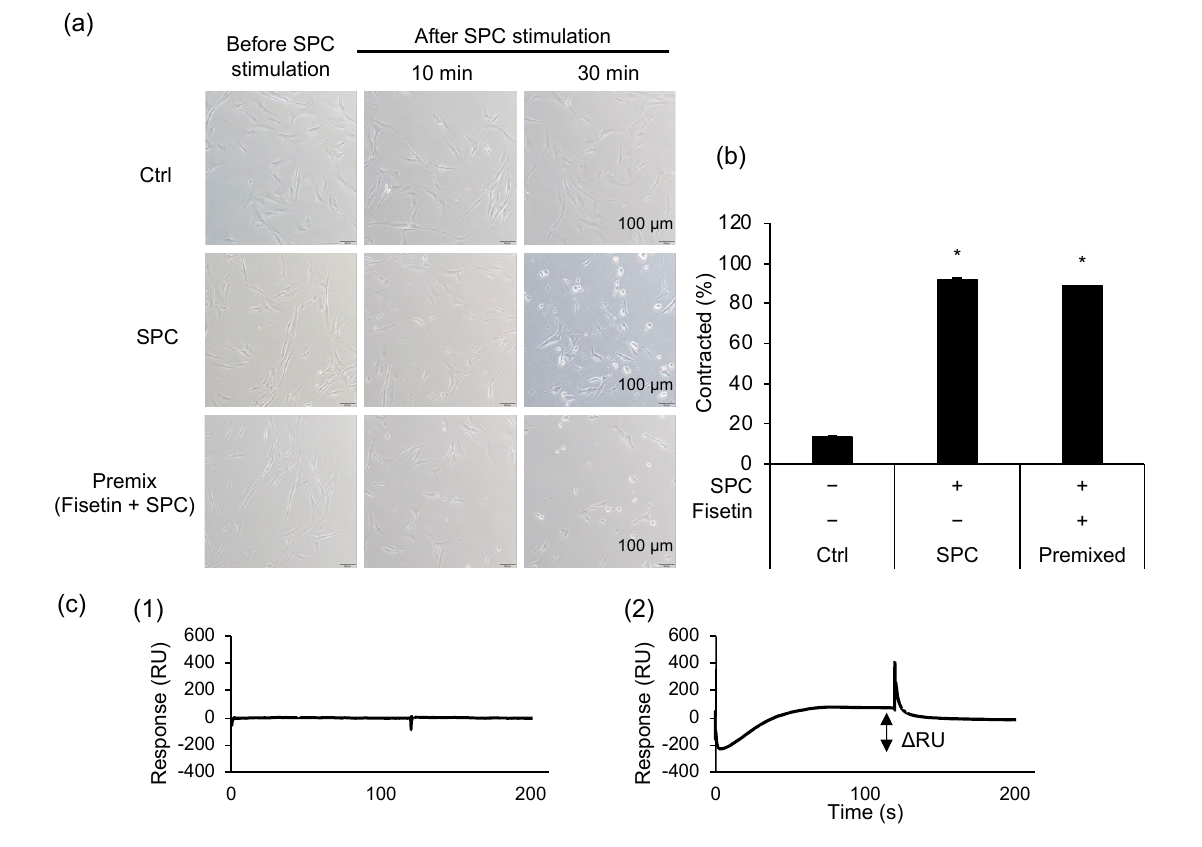
Figure 1. Fisetin does not interact directly with sphingosylphosphorylcholine (SPC), the causative factor of SPC-induced abnormal contraction. ( a ) Human coronary artery smooth muscle cells before and after SPC stimulation. Top row: control cells (Ctrl); middle row: SPC-stimulated cells; bottom row: SPC and fisetin premix-stimulated cells. The left column depicts cells before SPC stimulation, whereas the middle and right columns depict cells 10 or 30 min after SPC stimulation, respectively. ( b ) Contracted cell rates of Ctrl, SPC-, and premix-stimulated cells. Data are represented as mean ± standard deviation, * p < 0.05 vs. Ctrl. ( c ) Interaction between SPC and fisetin (1) or RNA aptamer (2). The solid line in the sensorgram indicates that fisetin does not interact with SPC, whereas the dashed line represents the binding curve of the RNA aptamer.